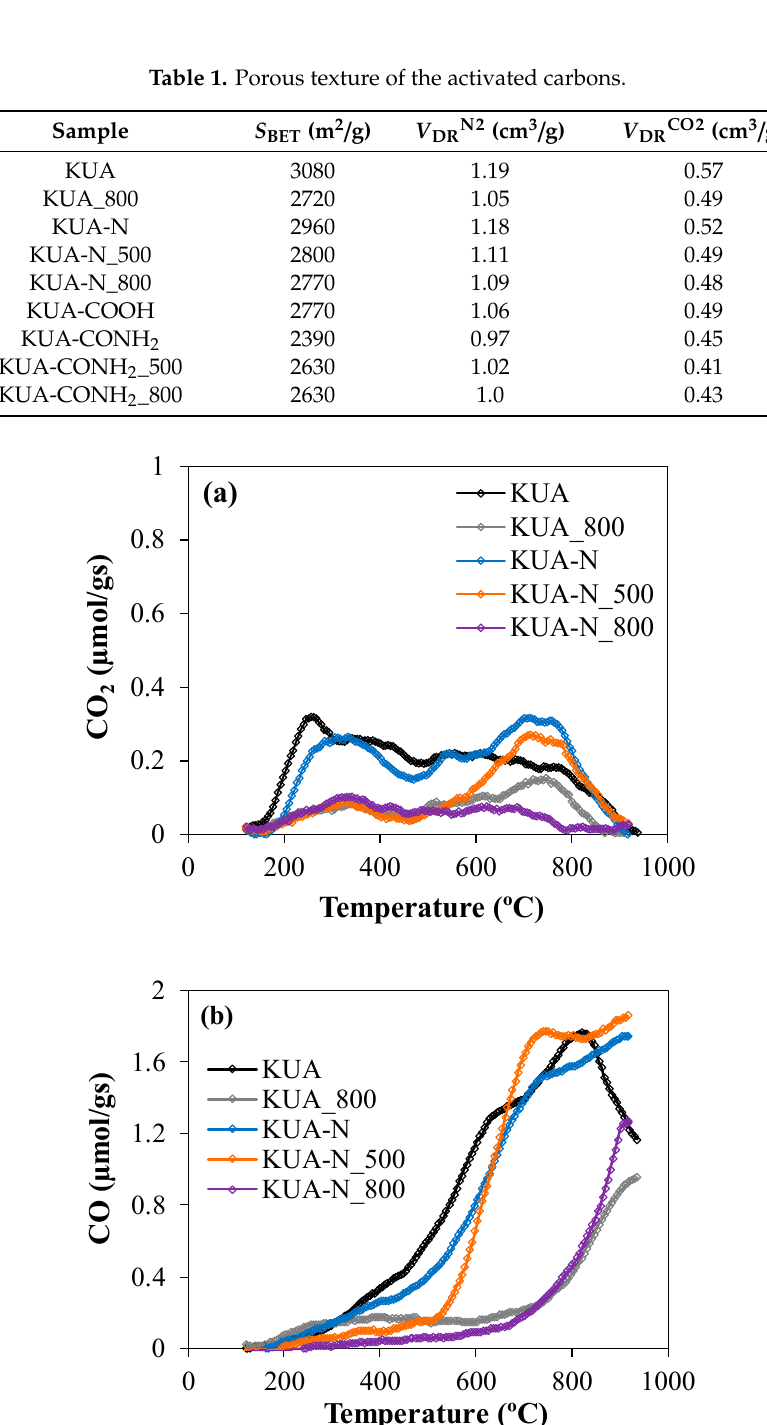
Figure 2. Comparison between ( a ) CO 2 and ( b ) CO TPD profiles of KUA, KUA_800, KUA-N, KUA-N_500 and KUA-N_800.